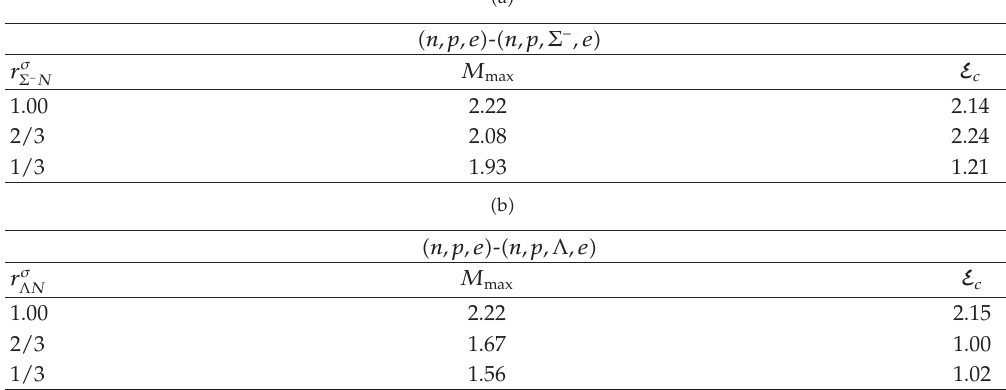
Table 2: The maximum masses, M max , and central energy densities, E C (cid:7) 10 15 g / cm 3 (cid:8) , of neutron stars produced by way of (cid:7) a (cid:8) (cid:7) n,p,e (cid:8) - (cid:7) n,p, Σ − ,e (cid:8) and (cid:7) b (cid:8) (cid:7) n,p,e (cid:8) - (cid:7) n,p, Λ ,e (cid:8) are listed, respectively, with the same coupling constants. The EOS of the hyperon phase (cid:7) n,p, Σ − ,e (cid:8) and (cid:7) n,p, Λ ,e (cid:8) is calculated with the (cid:5) g (cid:5) 1 . 0 , 2 / 3 , 1 / 3 (cid:3) 26 (cid:4) ratio r σ σH /g σN HN